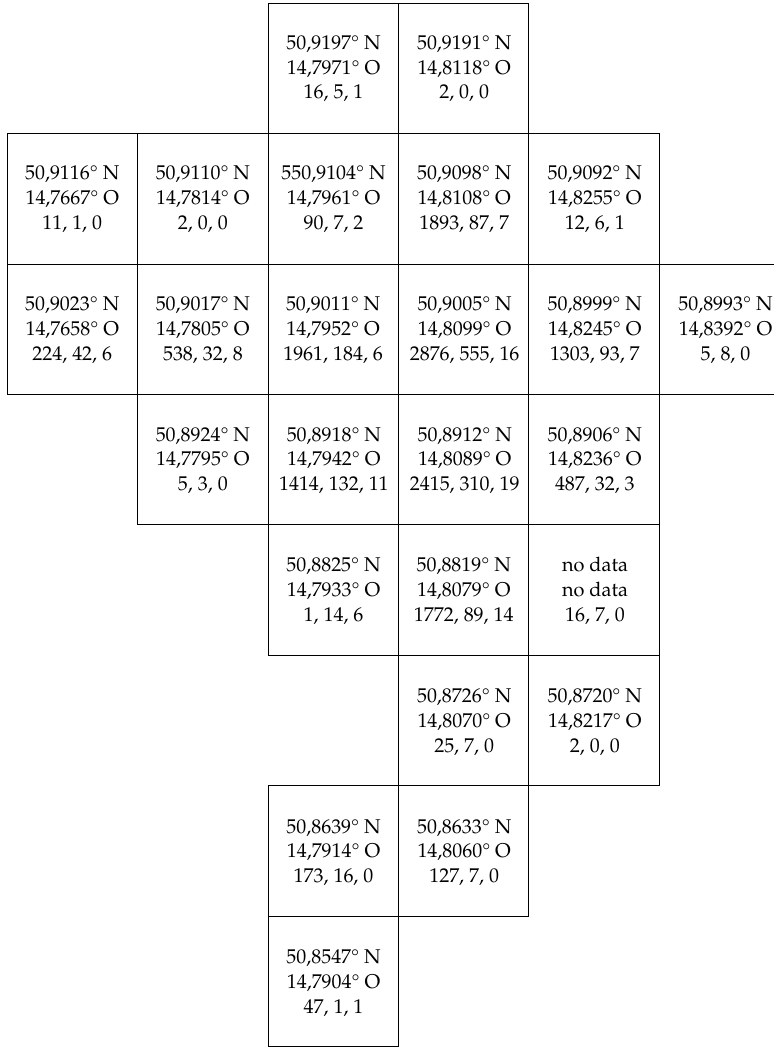
Figure A3. Details of the model’s supply